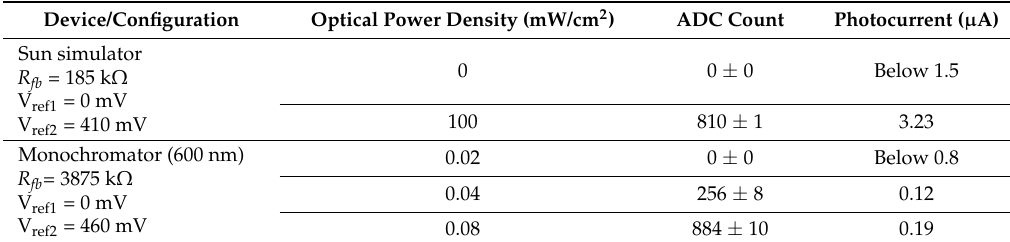
Table 1 . Sensor performance in the RFID tag. Table 1. Sensor performance in the RFID